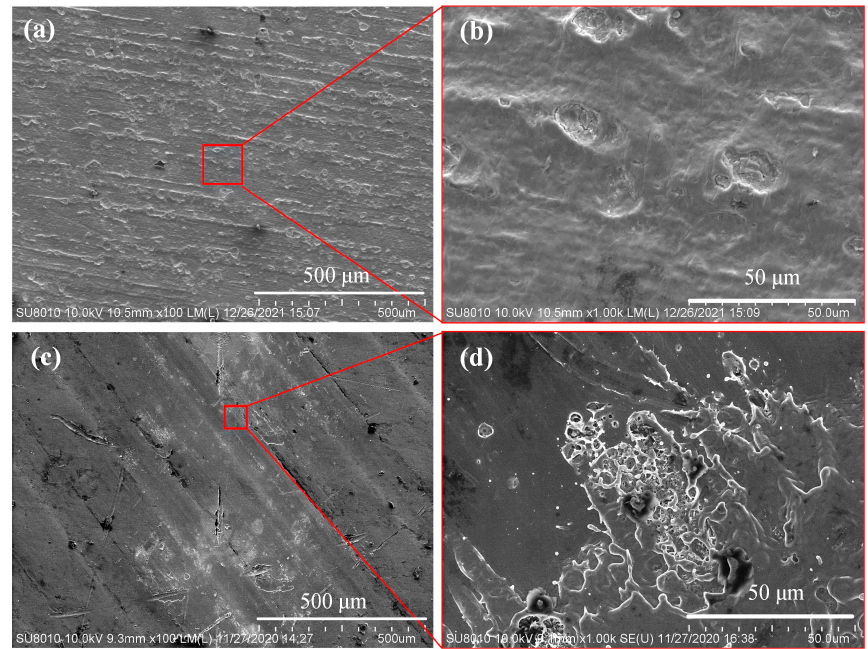
Figure 5 . 355-nm Nd:YAG laser irradiation of aluminum alloy 6061 at a fluence of 0.5 J/cm 2 after laser irradiation of 15 times. ( a ) With functional layers. ( b ) Enlarged view of ablation area of Figure 4a. ( c ) Without functional layers. ( d ) Enlarged view of ablation area of Figure 4c.